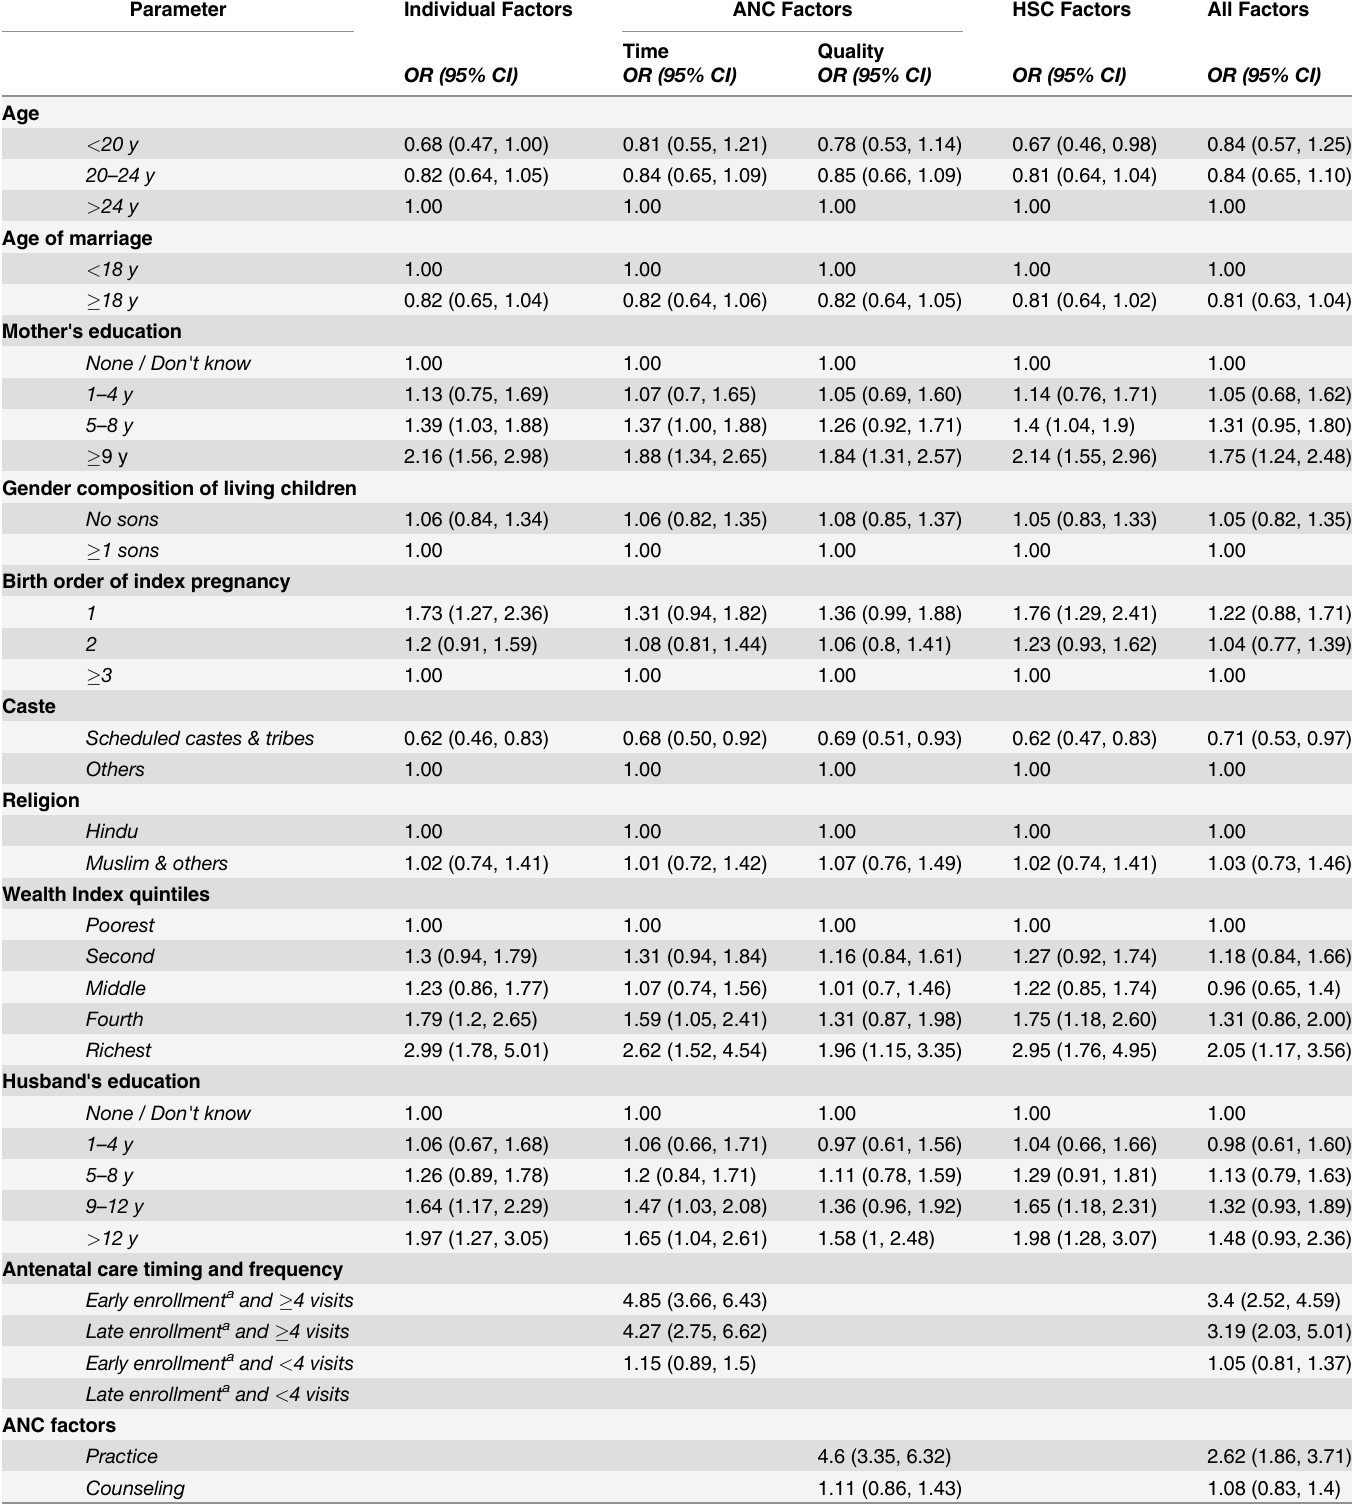
Table 7. Multilevel modeling of iron and folic acid consumption for (cid:1) 90 days during last pregnancy.